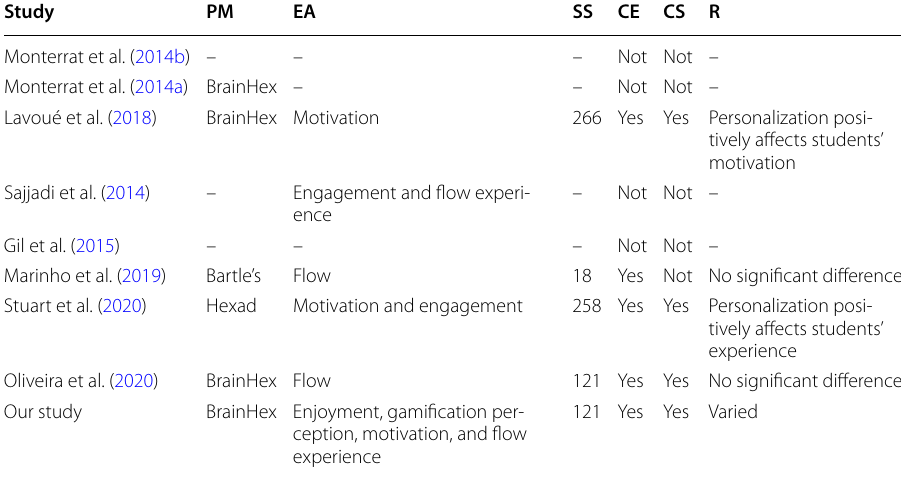
Table 1 Related works